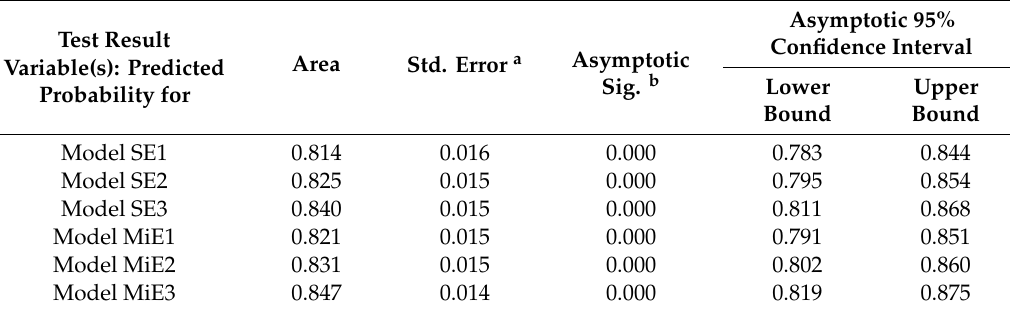
Table 2. Area under the curve (for SE and MiS models).